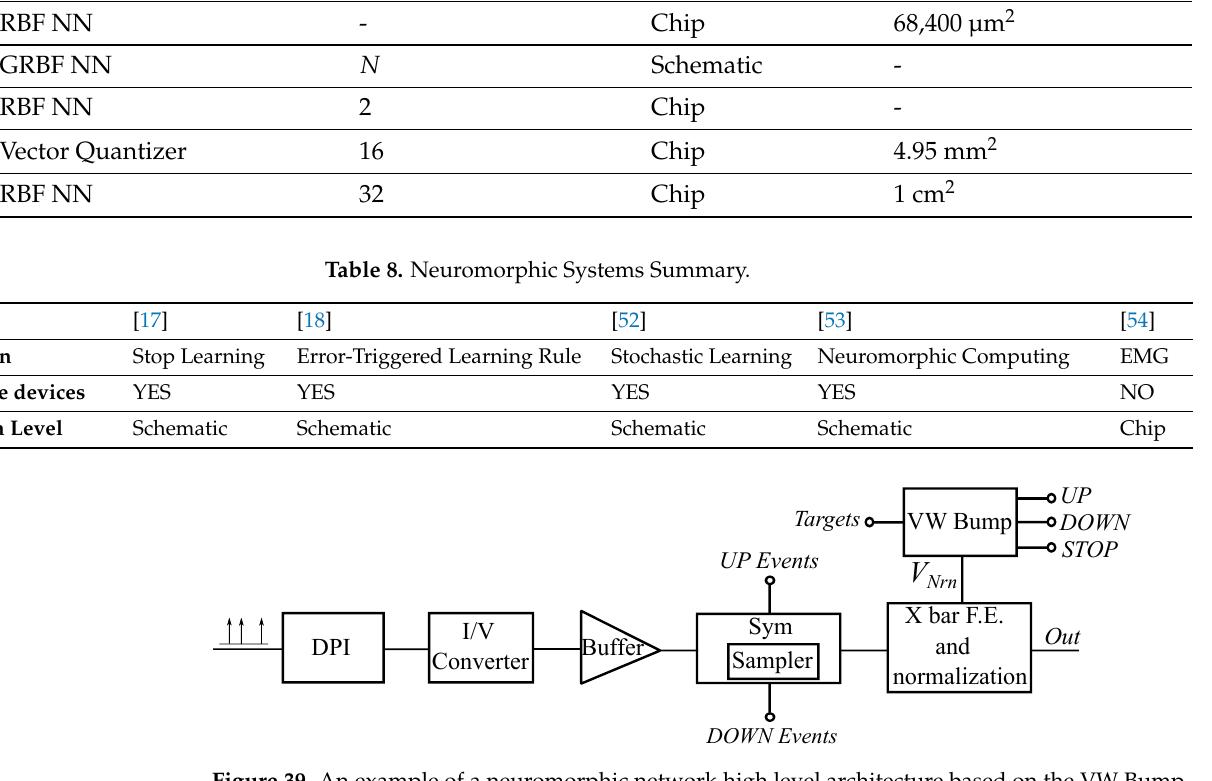
Figure 39. An example of a neuromorphic network high level architecture based on the VW